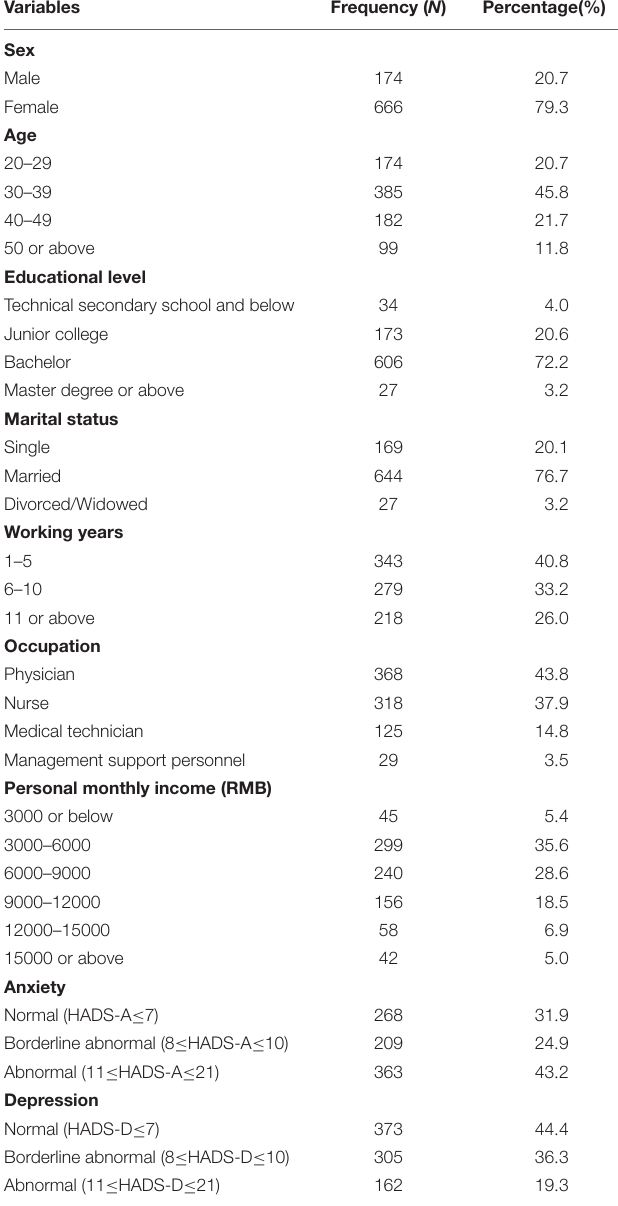
TABLE 1 | Sociodemographic characteristics of primary healthcare